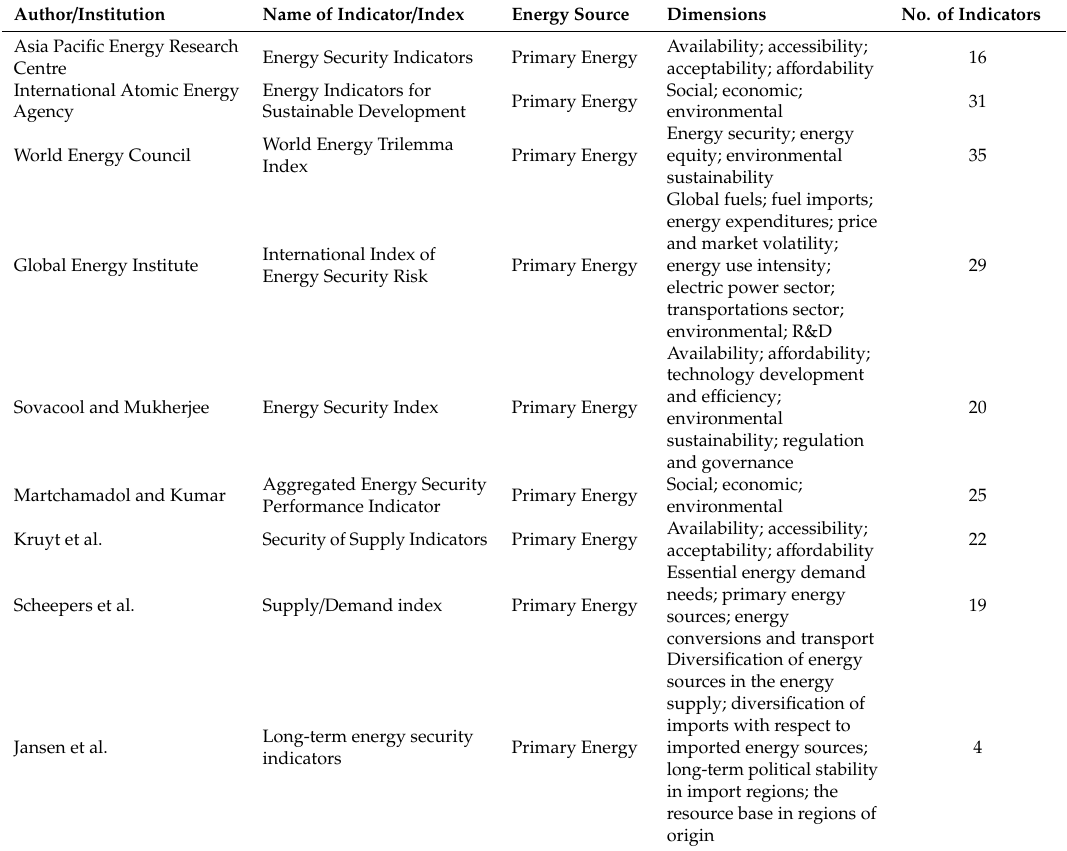
Table 1. Reviewed studies on energy